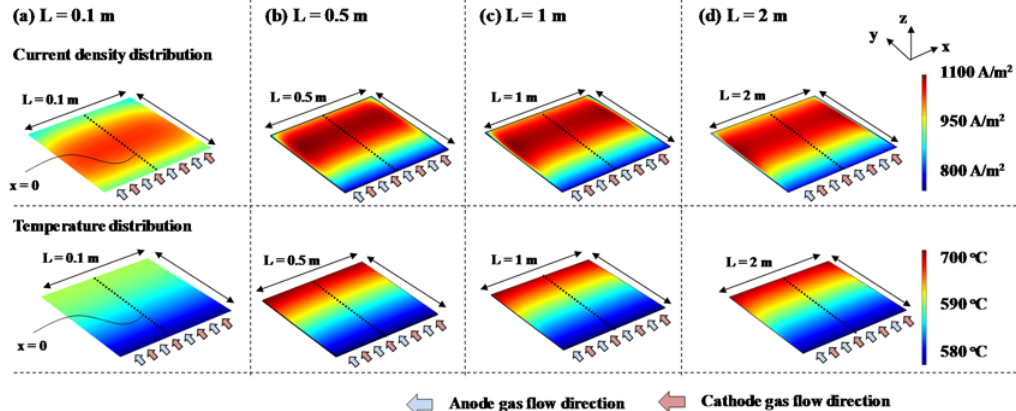
Figure 5. Current density and temperature distribution with respect to length (L) for the co ‐ flow type MCFCs at the average current density value of 1000 A/m 2.